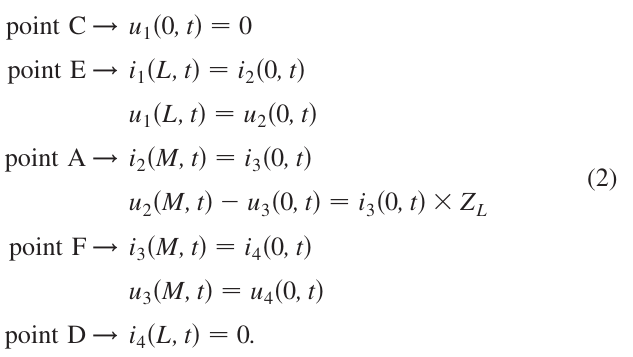
where u 1 ð X; t Þ , i 1 ð X; t Þ , u 2 ð Y; t Þ , i 2 ð Y; t Þ , u 3 ð Z; t Þ , i 3 ð Z; t Þ , u ð W; t Þ , and i ð W; t Þ are voltage and current of the inner 4 4 line, transition section and outer line, respectively. L 1 , L 2 , L C C C 3 , 1 , 2 , and 3 are inductance and capacitance of per